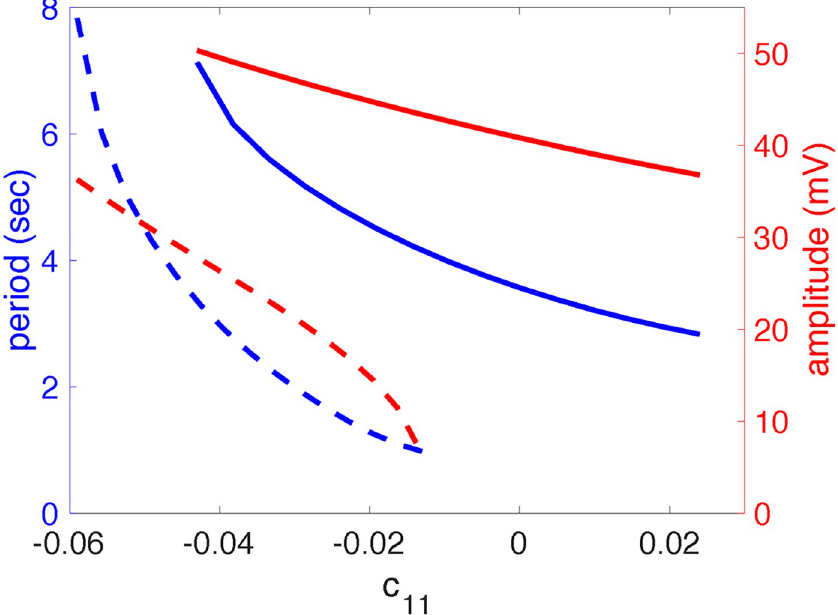
Fig 3. Pre-I output properties are altered by embedding within the full respiratory network. Dashed curves show the period (blue) and amplitude (red) of oscillations exhibited by the pre-I unit in isolation, over the range of c 11 values for which it intrinsically generates oscillatory behavior. Solid curves illustrate the same quantities for the pre-I unit when it is embedded in the full model respiratory network, over the range of c 11 values for which the network